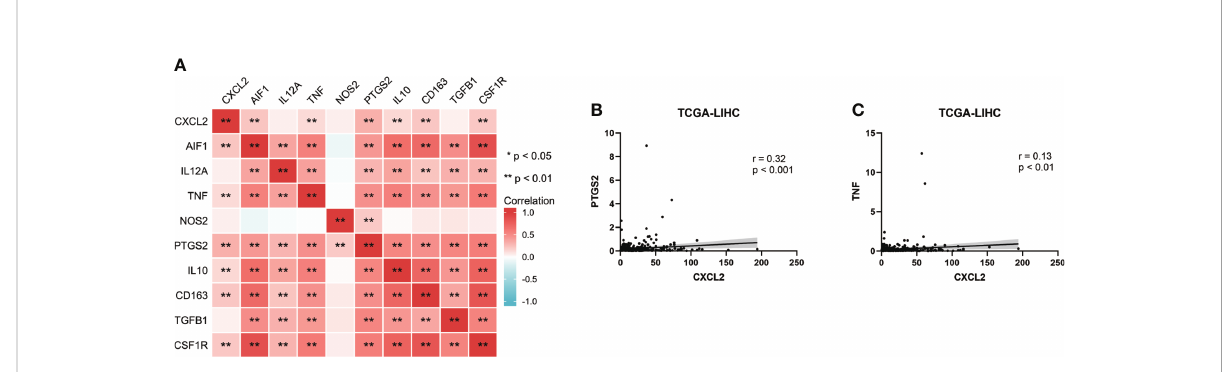
FIGURE 7 CXCL2 associated with M1 macrophage in HCC. (A) Heat map of correlation between CXCL2 and classical macrophage phenotype markers. (B, C) Scatter plots showing the association between CXCL2 and M1 macrophage markers (PTGS2 and